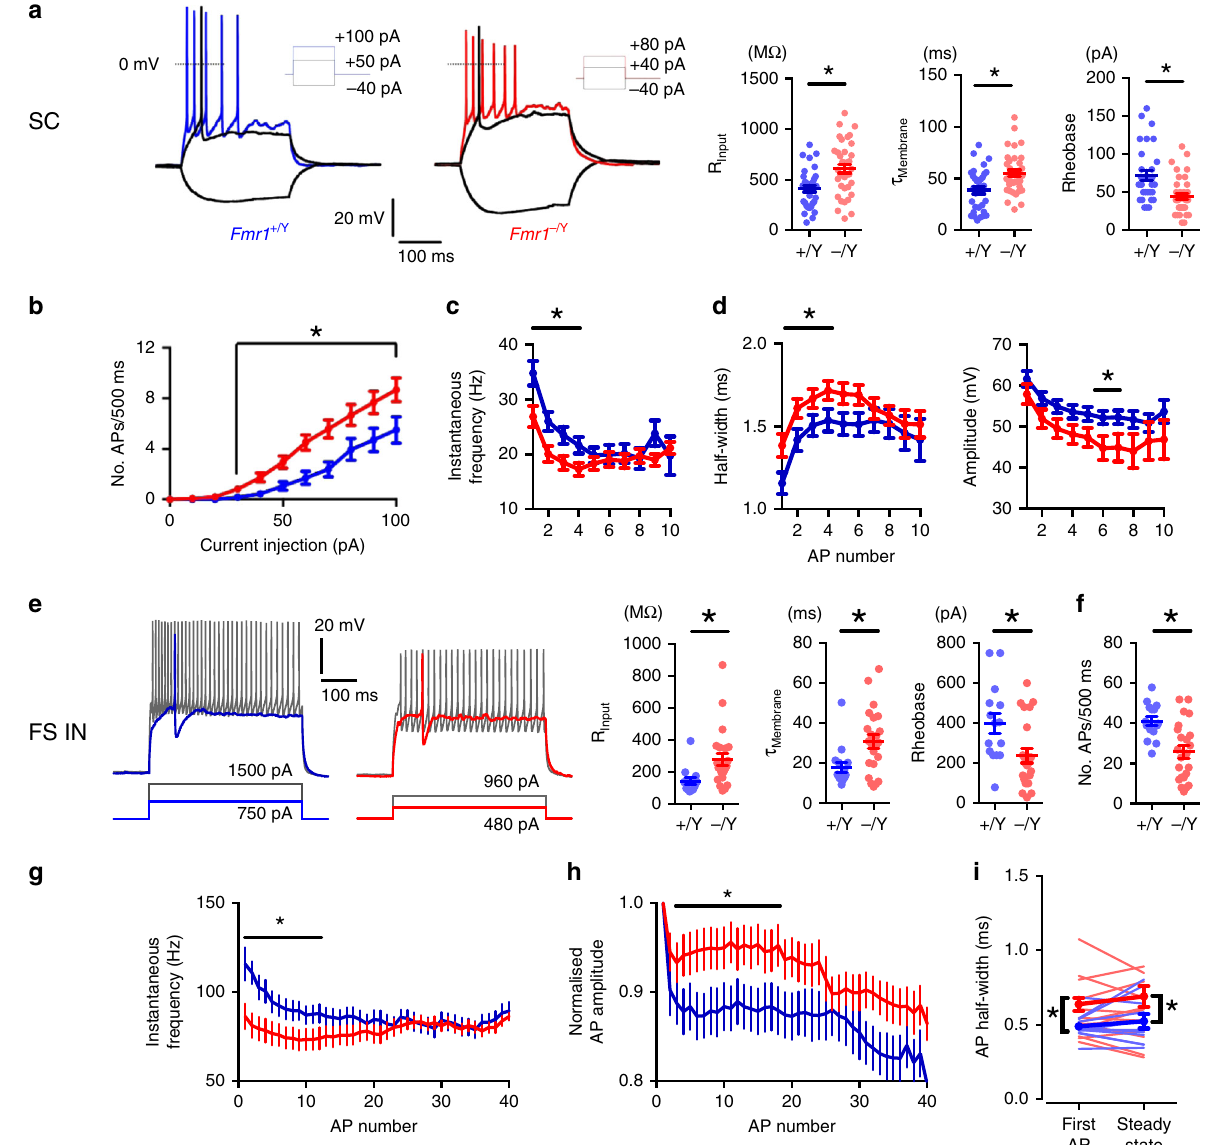
Fig. 1 Altered intrinsic properties of Fmr1-KO Layer 4 SCs and FS interneurons. a Left: Example fi ring characteristics of layer 4 excitatory neurons in response to 500ms hyper/depolarizing current injections ( − 40pA, rheobase, 2× rheobase shown). Right: Passive membrane and intrinsic properties of L4 excitatory neurons: Input resistance ( Fmr1 + /Y : 412±33M Ω , Fmr1 − /Y : 609 ±43 M Ω , p = 0.0007), Membrane time constant ( Fmr1 + /Y : 39 ±3.7ms, Fmr1 − /Y : 55±3.2ms, p = 0.0015), Rheobase current ( p <0.002, Fmr1 + /Y : 72±6.6pA; N = 33, Fmr1 − /Y : 44±4.0pA; N = 37). Not shown: Membrane capacitance ( Fmr1 + /Y : 94± 6.7pF, Fmr1 − /Y : 89±4.9pF, p = 0.56), resting membrane potential ( Fmr1 + /Y : − 64 ±1.7mV, Fmr1 − /Y : − 64±1.3 mV, p = 0.88). All statistics herein: Student ’ s t -test, two-tailed. b Suprathreshold current-spike frequency (FI) responses of L4 Fmr1 − /Y excitatory neurons were signi fi cantly steeper for current injections> 30pA ( p = 0.02, Mann – Whitney, Fmr1 + /Y : 120 ±10Hz/nA, Fmr1 − /Y : 200 ±12Hz/nA ( n : 28 Fmr1 + /Y , 28 Fmr1 − /Y ). c SC fi ring rate during twice-rheobase current injections. Asterisks: p <0.05, t -tests comparing values for each spike position in train, N : Fmr1 + /Y = 50 neurons, Fmr1 − /Y = 42 neurons. d SC action potential half-width and amplitude during entrained fi ring to twice-rheobase current injections. Statistics as ( c ). e Left: Example spike waveforms fi red by FS interneurons in response to 500 ms depolarizing current injections (rheobase, 2× rheobase shown). Right: passive membrane and intrinsic properties of FS interneurons (Asterisks: p <0.05, t -test, N (neurons): Fmr1 + /Y = 15, Fmr1 − /Y = 23). f – h FS overall action potential rate ( f ), fi ring rate accommodation ( g ) and amplitude accommodation ( h ) during entrained fi ring to twice-rheobase current injections. Statistics as in ( e ). i Reduced rate of AP fi ring in Fmr1 − /Y FS interneurons as analysed by instantaneous frequency (1/inter-spike interval) of fi rst and last two APs in train Light colours indicate individual neurons, thick bars/lines are mean±SEM for each genotype. Asterisks on left and right graphs indicate parameters signi fi cantly different between genotypes compared by t - test ( p <0.05, N (neurons): Fmr1 + /Y = 15, Fmr1 − /Y = 27). Asterisks on centre graph indicate signi fi cantly different mean frequencies between genotypes compared by one-way ANOVA with Bonferroni ’ s correction for multiple comparisons ( p < 0.05, N : Fmr1 + /Y = 15, Fmr1 − /Y =